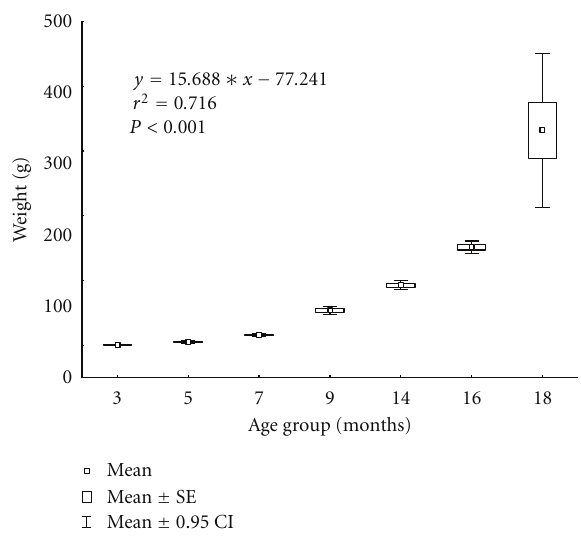
Figure 4: Fish weight during the monitoring period.